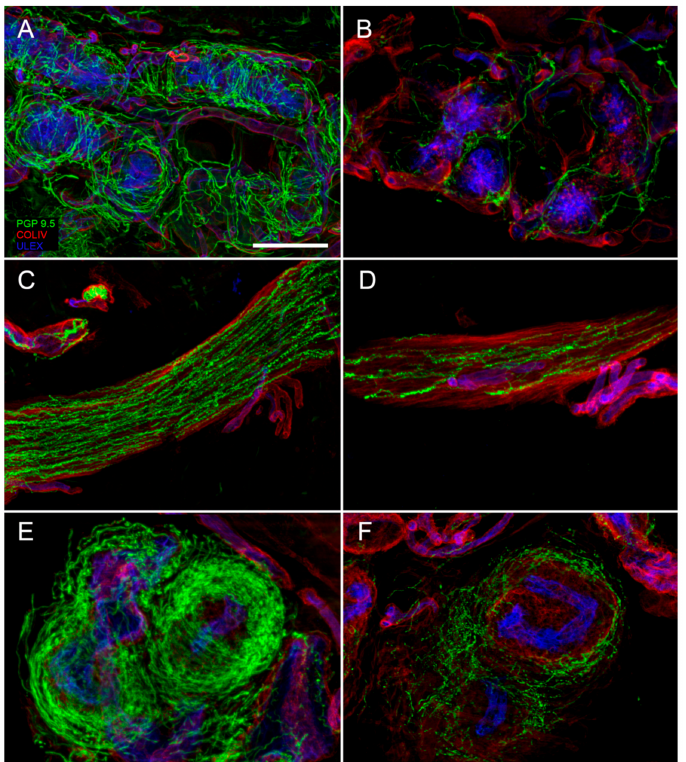
Figure 2. Confocal digital images showing a loss of cutaneous autonomic nerves in a diabetic neuropathy patient ( B , D , F ) compared to a healthy control ( A , C , E ). In patient skin it is evident a loss of nerves around a sweat gland (( B ) compared to ( A )), along an arrector pili muscle (( D ) compared to ( C )) and around an arterio-venous anastomosis (( F ) compared to ( E )). In green: nerves marked with the pan-neuronal marker, protein gene product 9.5 (PGP 9.5) antibody. In red: basal membranes and vessels marked with Collagen IV antibody. In blue: endothelia marked with ULEX europaeus ( A – F ). Scale bar: 100 µ